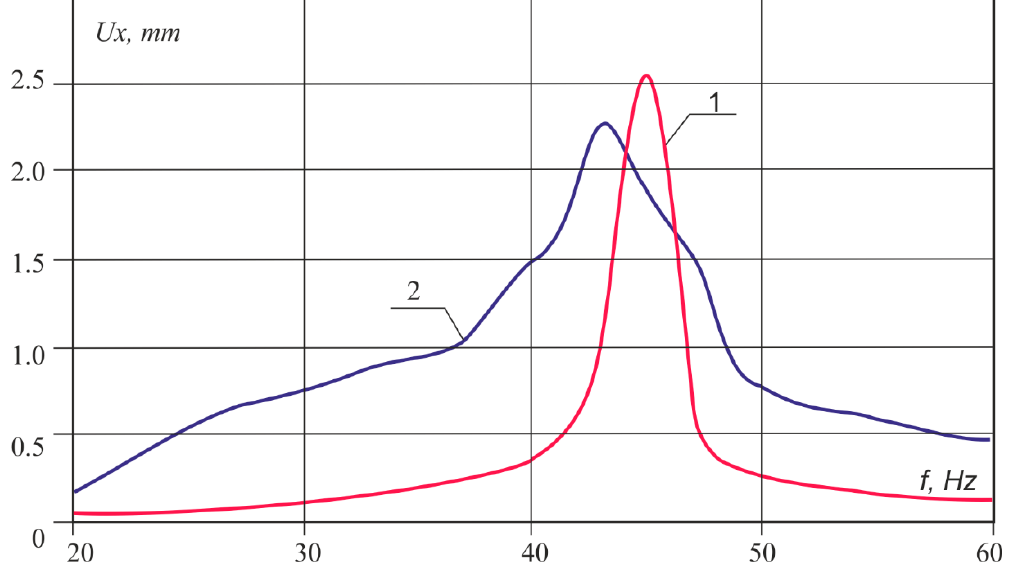
Figure 12. Response spectra of underpass overlap: 1, theoretical; 2, experimental.